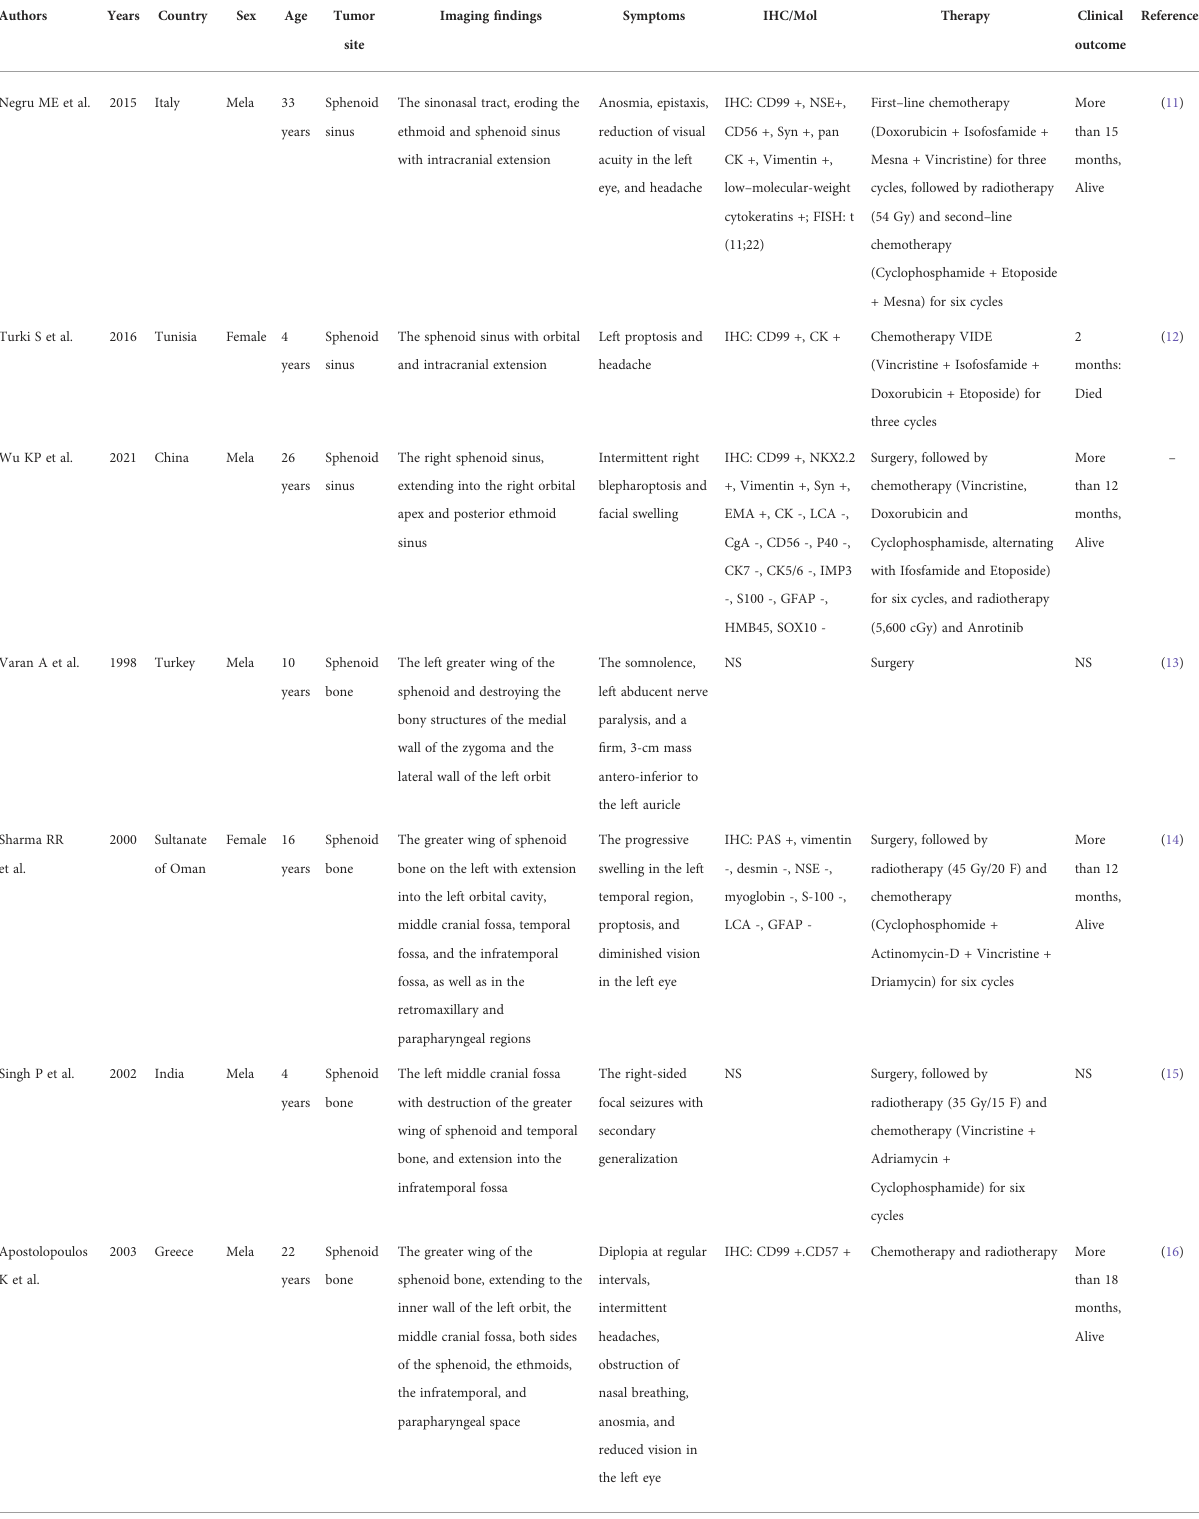
TABLE 1 Primary Ewing ’ s sarcoma of sphenoid sinus and bone in the literature.